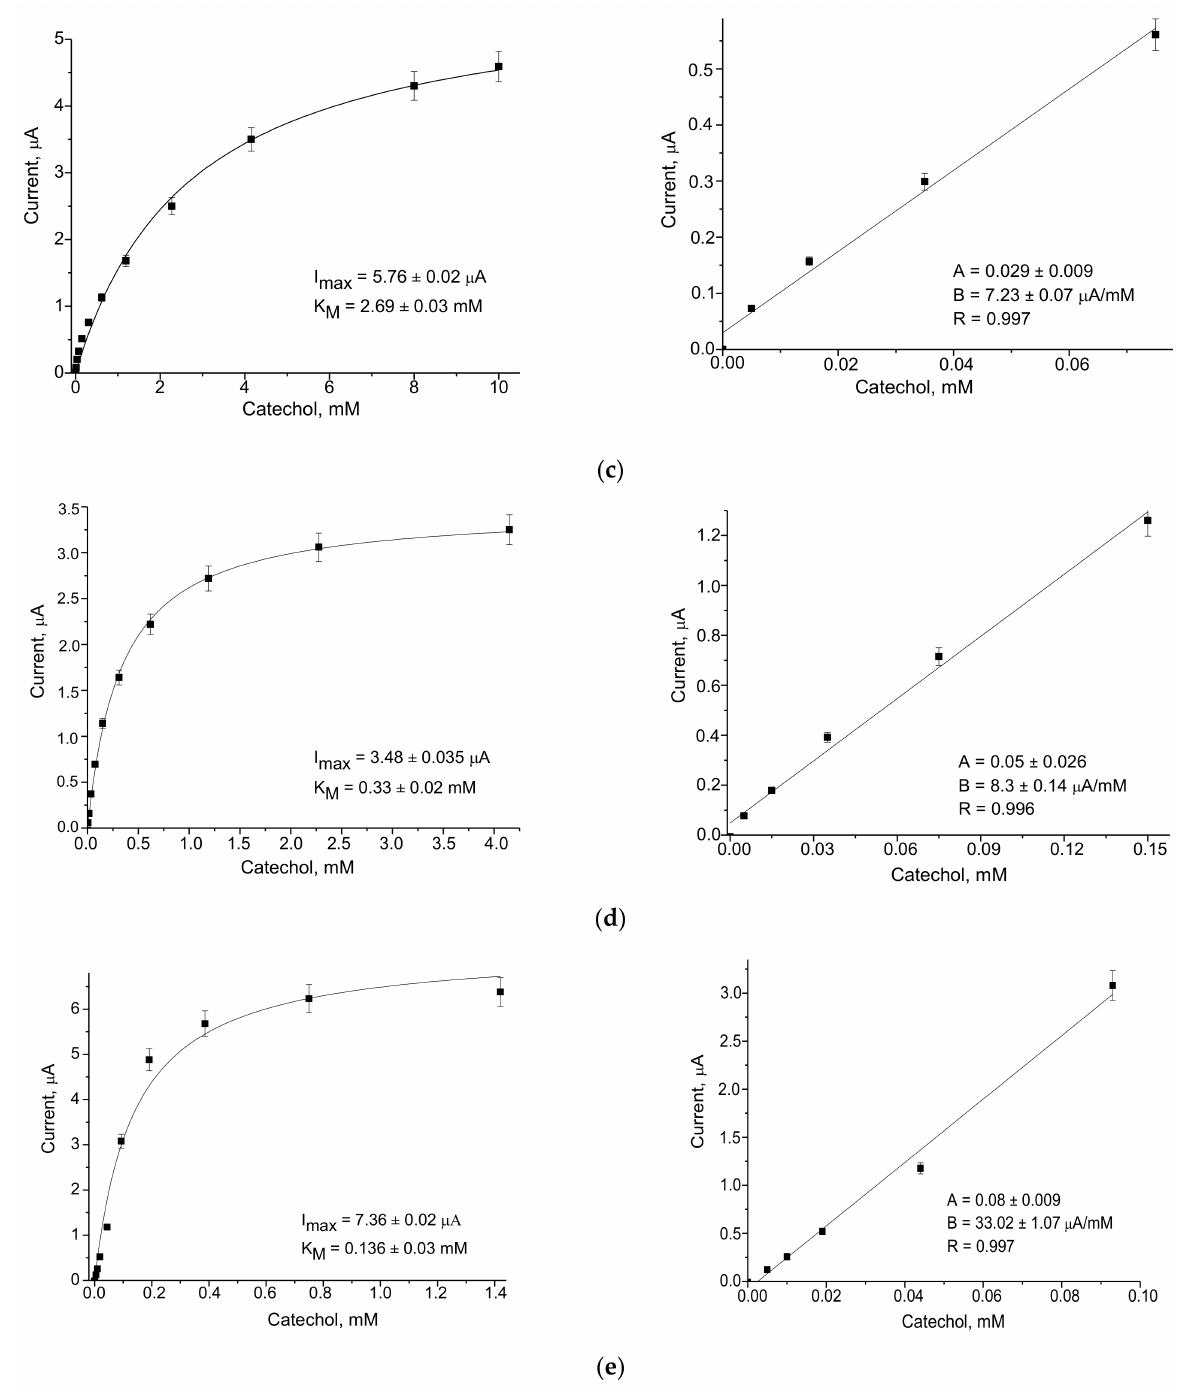
Figure 4. Calibration curves for catechol determination in wide (left) and linear (right) ranges using the highly sensitive ABSs: ( a ) control electrode laccase/GE without NPs; ( b ) laccase/AgHCF/GE, ( c ) laccase/NiPtPd/GE, ( d ) laccase/PdHCF/GE, ( e ) laccase/CuCo/GE. Abbreviations: B—slope of the calibration graph; R—the correlation coefficient of linear